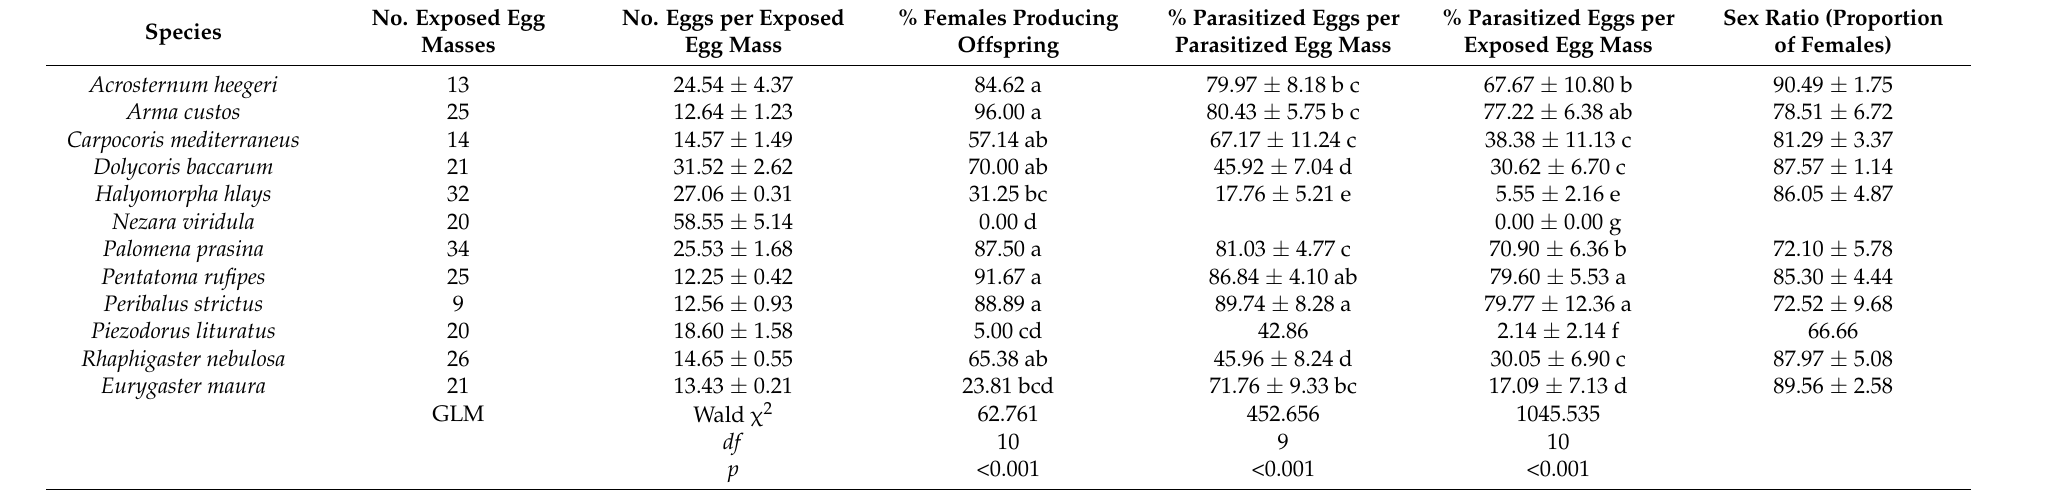
Table 2. Outcomes of no-choice tests: numbers of exposed egg masses (=no. of tested Trissolcus kozlovi females) and mean numbers ( ± SE) of eggs per exposed egg mass, percentages of females producing offspring, mean percentage ( ± SE) of offspring emergence within each parasitized egg mass and within each exposed egg mass of the tested bug species, and mean proportion ( ± SE) of females per parasitized egg mass. In columns, values followed by the same letter are not significantly different (Bonferroni test, p < 0.05, under GLM procedure with binomial distribution and logit